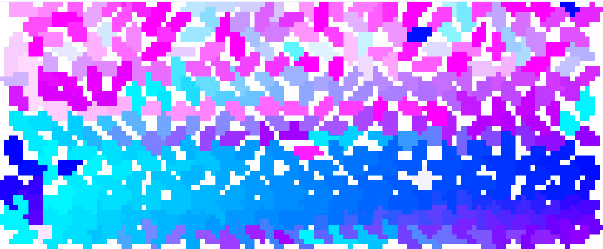
Figure 2. The top view of 400 agents with randomly assigned colors when the bottom wall moves toward the top wall by 1 m.